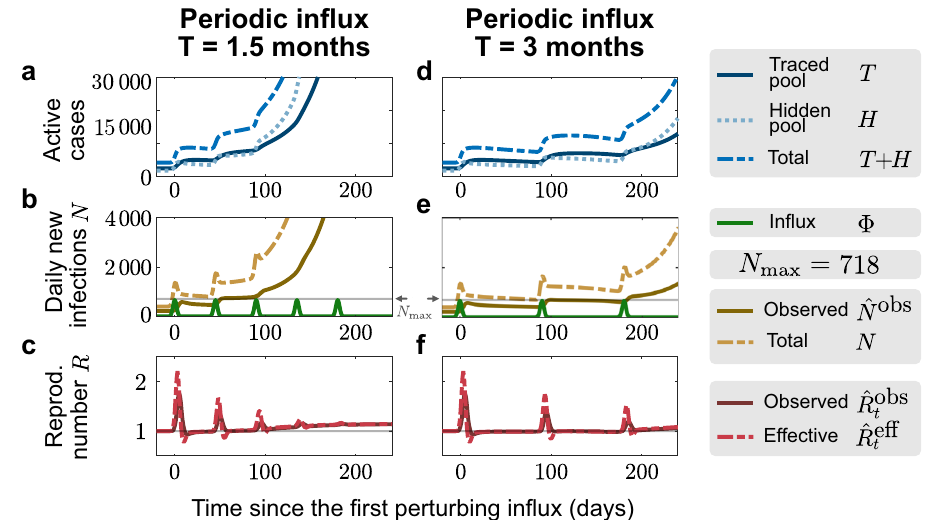
Fig. 4 Manageable in fl ux events that recur periodically can overwhelm the tracing capacity. For the default capacity scenario, we explore whether periodic in fl ux events can overwhelm the tracing capacity: A ‘ manageable" in fl ux that would not overwhelm the tracing capacity on its own (3331 externally acquired infections, 92% of which occur in 7 days) repeats every 1.5 months ( a – c ) or every 3 months ( d – f ). In the fi rst case, the system is already unstable after the second event because case numbers remained high after the fi rst in fl ux ( b ). In the second case, the system remains stable after both the fi rst and second event ( e ), but it becomes unstable after the third ( f From thereon, the tracing system breaks down, and the growth self-accelerates. This is re fl ected in the steep rise of new cases after day 100 — thus with a considerable delay after the change of R H i.e., the population ’ s behavior.